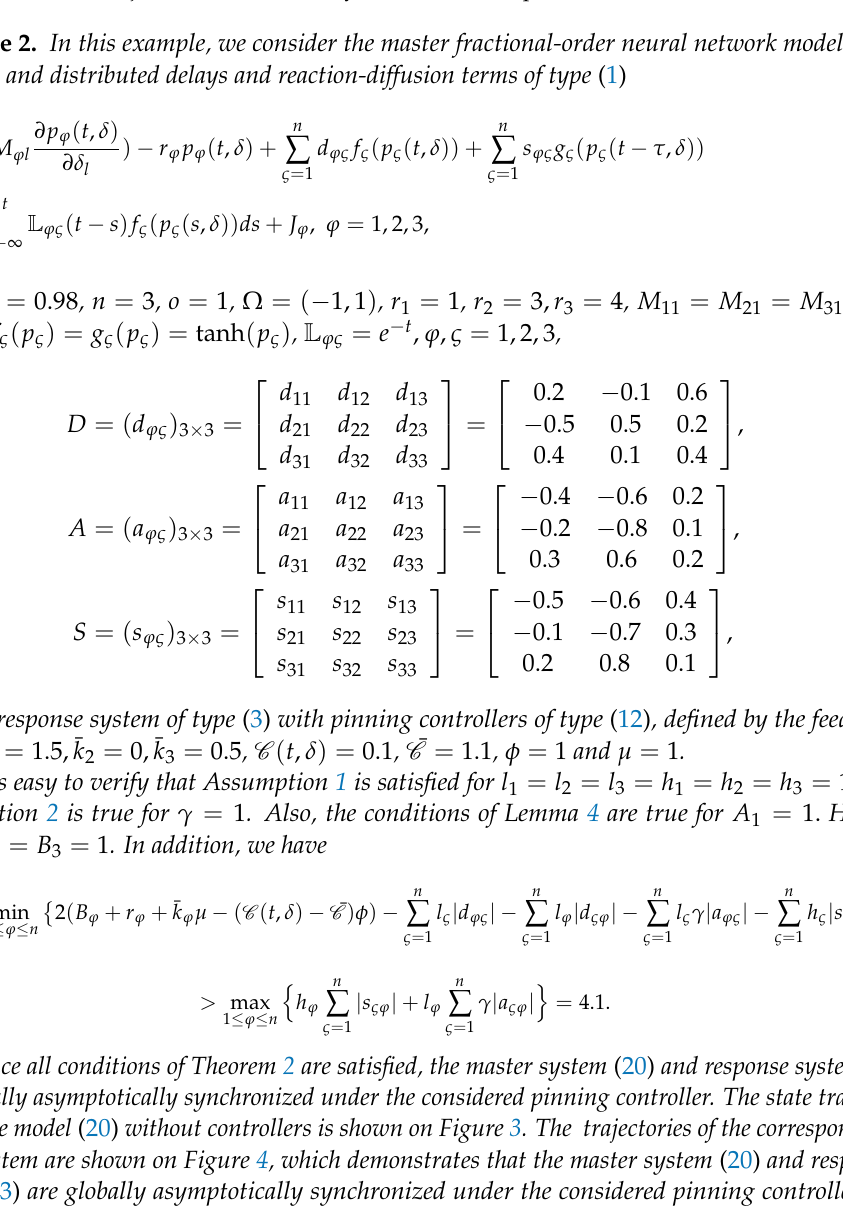
Figure 2. The state trajectories of the error system (8) in Example 1 with controller